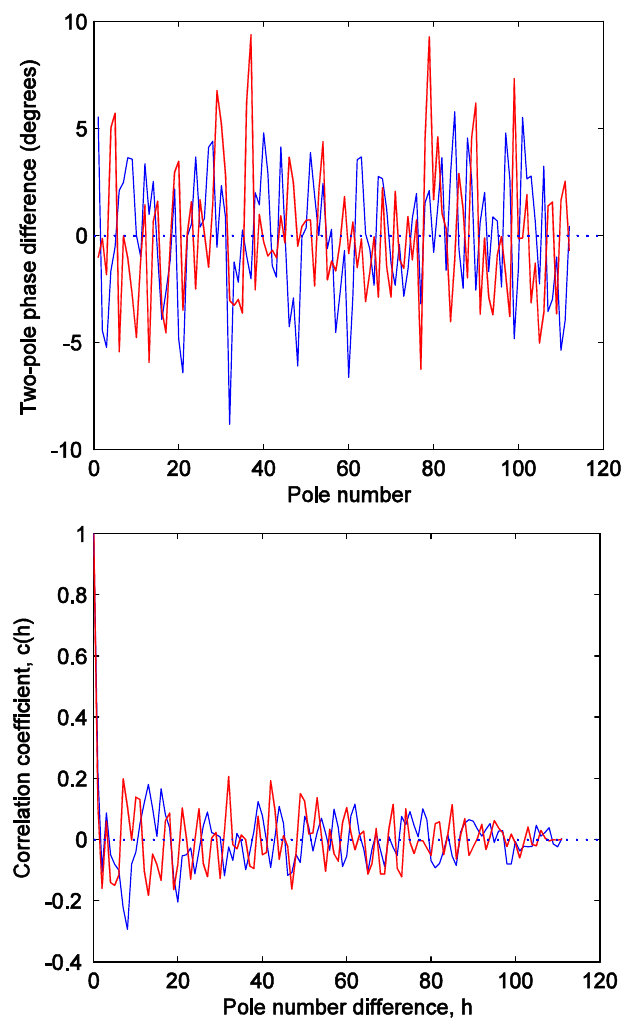
FIG. 8. Two-pole phase error differences (upper) and autocor- relation coefficients (lower) for the APS low (blue) and high (red) phase error